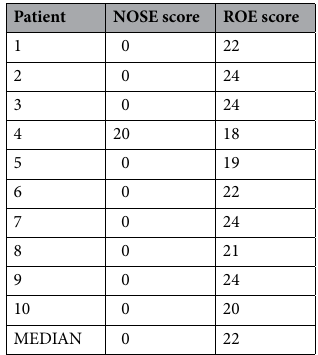
Table 2. Postoperative evaluaion on NOSE and ROE scores in patients reconstructed with expanded forehead flap. NOSE nasal obstruction symptom evaluation, ROE rhinoplasty outcome evaluation, SD standard